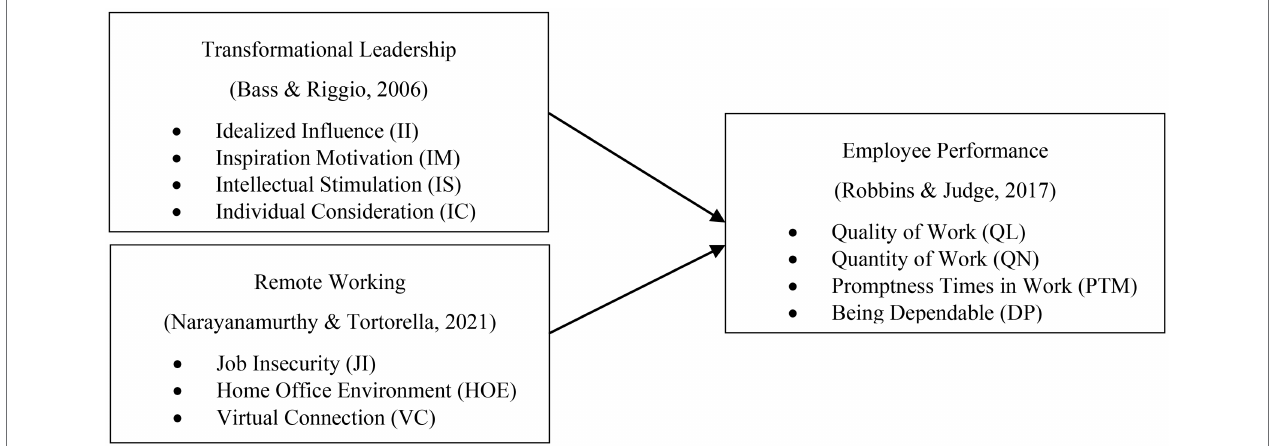
FIGURE 1 | Conceptual framework.